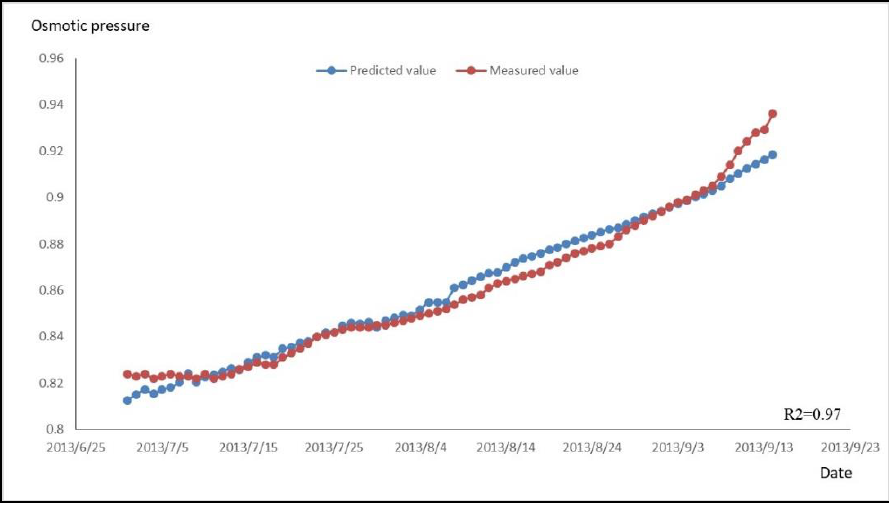
Figure 10. Osmotic Pressure Measured and Predicted Value Process Chart during Water-Storage Period. A goodness of fit of R 2 = 0.97 indicates that the fitting effect is good and that the regression equation can be used to predict the osmotic pressure during the water-storage period.